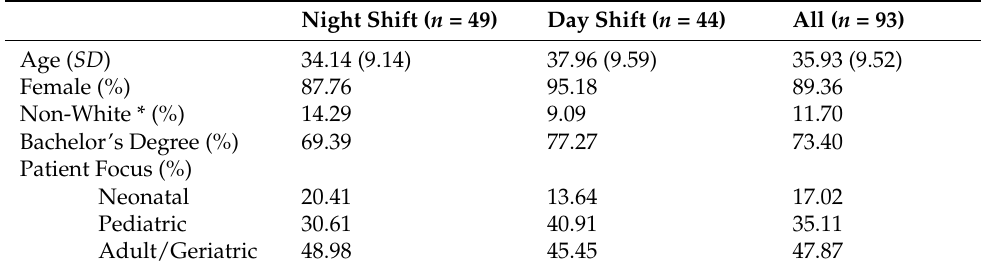
Table 1. Sample Characteristics by Shift